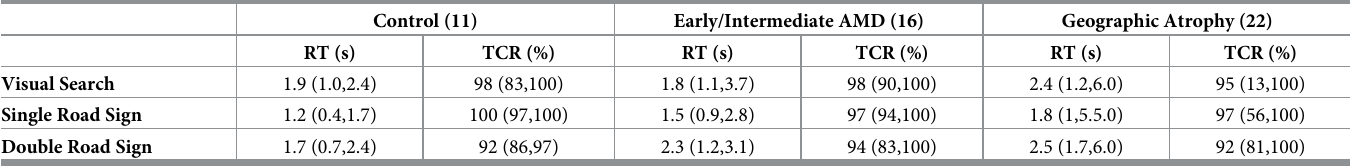
Table 2. Median (IQR) task response times (seconds; s) and total correct